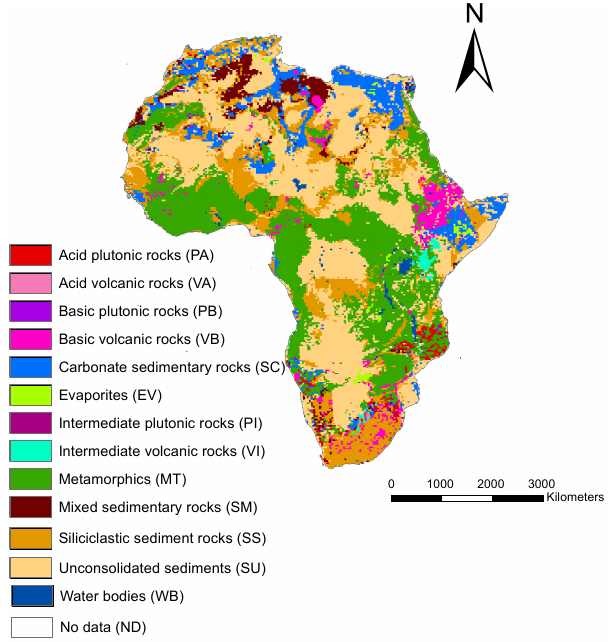
Figure 1. Hydrogeological setting of the African continent (from Hartmann and Moosdorf,